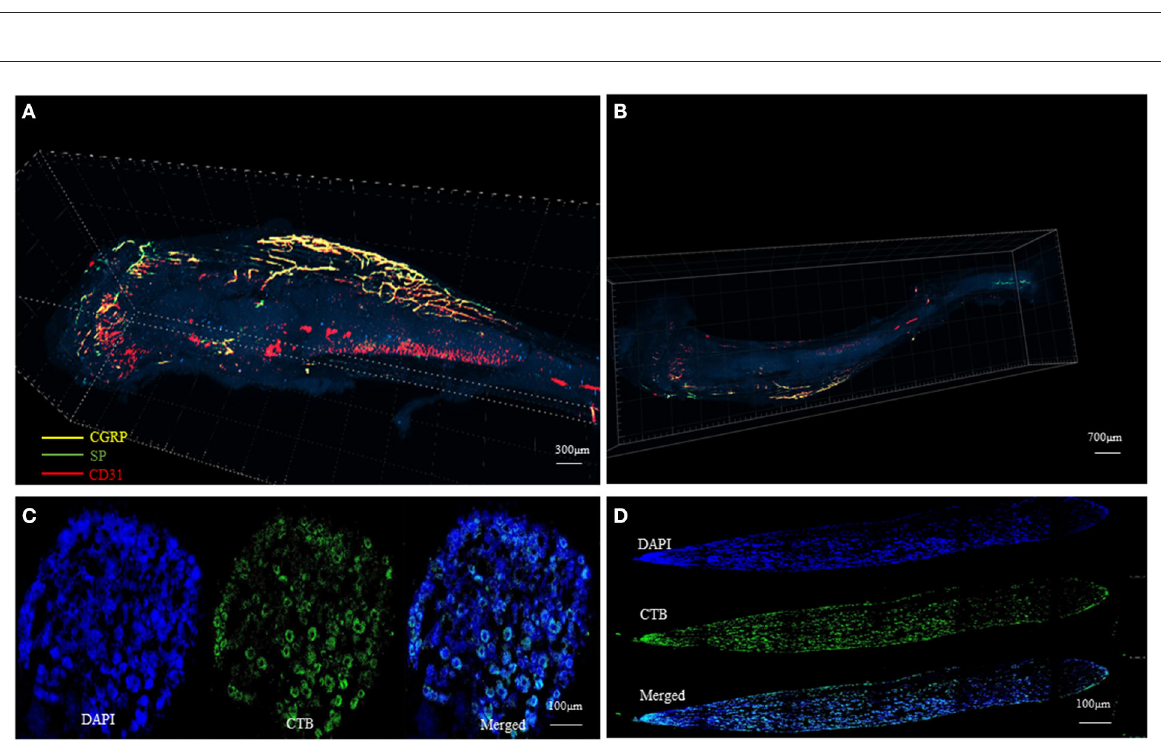
FIGURE3 Tissue clearing of the mouse femur bone and intrabony nerves (Unpublished data). (A, B) Representative figures of intrabony nerves staining by tissue transparent staining. (C, D) Retrograde tracing of intramedullary nerves to the superior cervical neurons (D) and sympathetic ganglia (C)